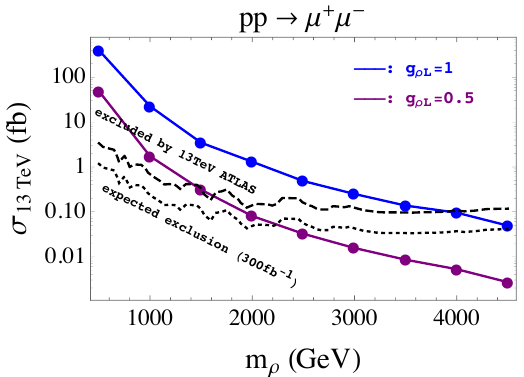
Figure 8 . Naive constraint on (cid:27) ( pp ! (cid:22) + (cid:22) (cid:0) ) for (cid:18) D = 0, (cid:18) L = (cid:25)= 2 and g (cid:26)L = 0 : 5 ; 1, where the latest experimental result provided by the ATLAS group is obtained from ref. [143]. The regions above the black dashed (black dotted) lines are excluded (expected to be excluded after a 300 fb (cid:0) 1 integrated luminosity accumulation) at 95%